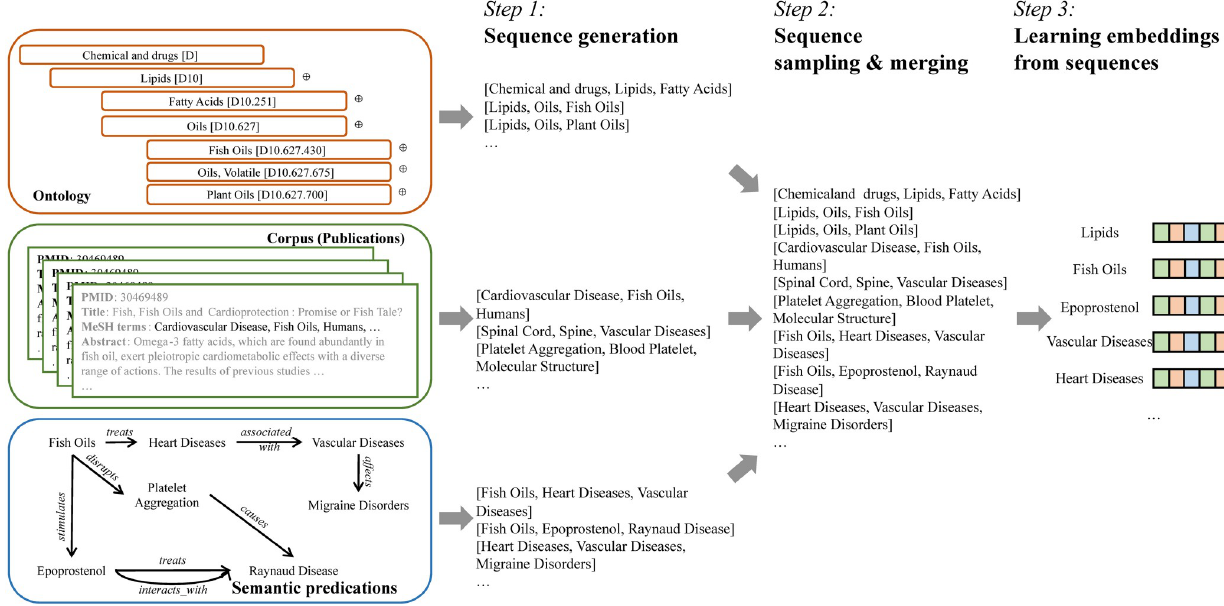
Fig 2. Our proposed solution. COS firstly generates MeSH term sequences from each data source. It then samples each group of generated sequences to the same number of sequences and merges them into one set of MeSH term sequences. Finally, COS learns the MeSH term embeddings based on the sequences